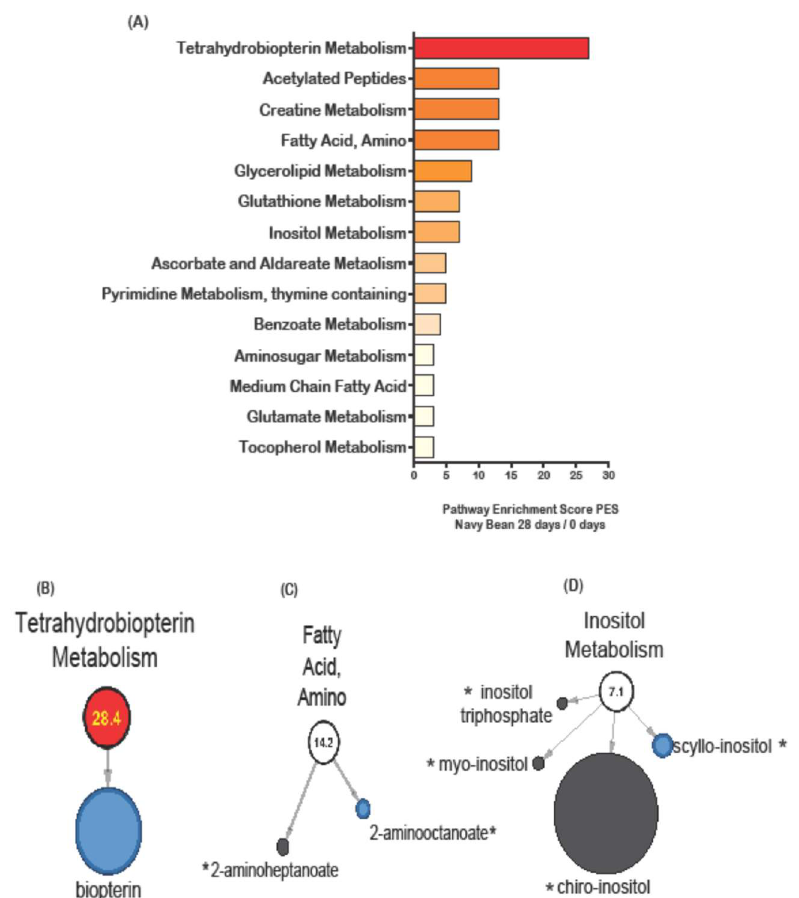
Figure 2. Stool metabolic pathways impacted by navy bean consumption as measured by pathway enrichment score (PES) for day 28 when compared to day 0 (baseline). ( A ) All stool metabolic pathways with a PES >2.0 are shown. Selected pathways with metabolites were shown for ( B ) tetrahydrobiopterin (1 metabolite) PES 28.4 ( C ) fatty acid, amino (2 metabolites) PES 14.2, and ( D ) inositol metabolism (4 metabolites), PES 7.1. Metabolites with black node were not significantly changed by beans. Red nodes indicate significantly increased metabolite abundance and blue node represents significantly decreased metabolite after consuming navy beans for 28 days compared to baseline (day 0). The size of the circle reflects the relative abundance scaled to all stool metabolites. The * indicates presence in the navy bean metabolome.